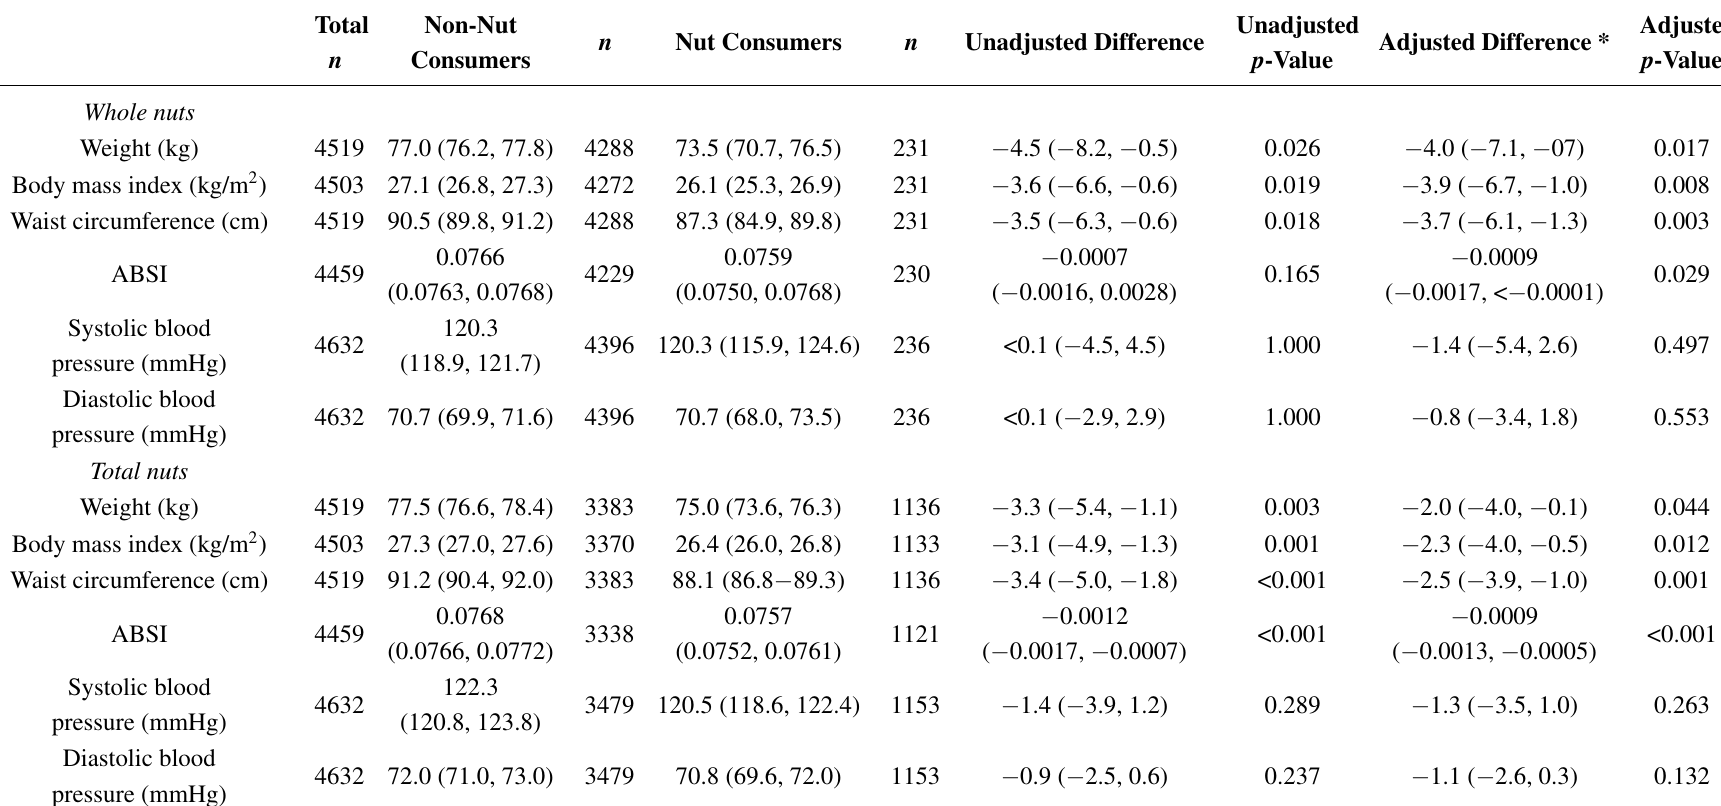
Table 2. Mean (95% CI) body composition and blood pressure among nut and non-nut